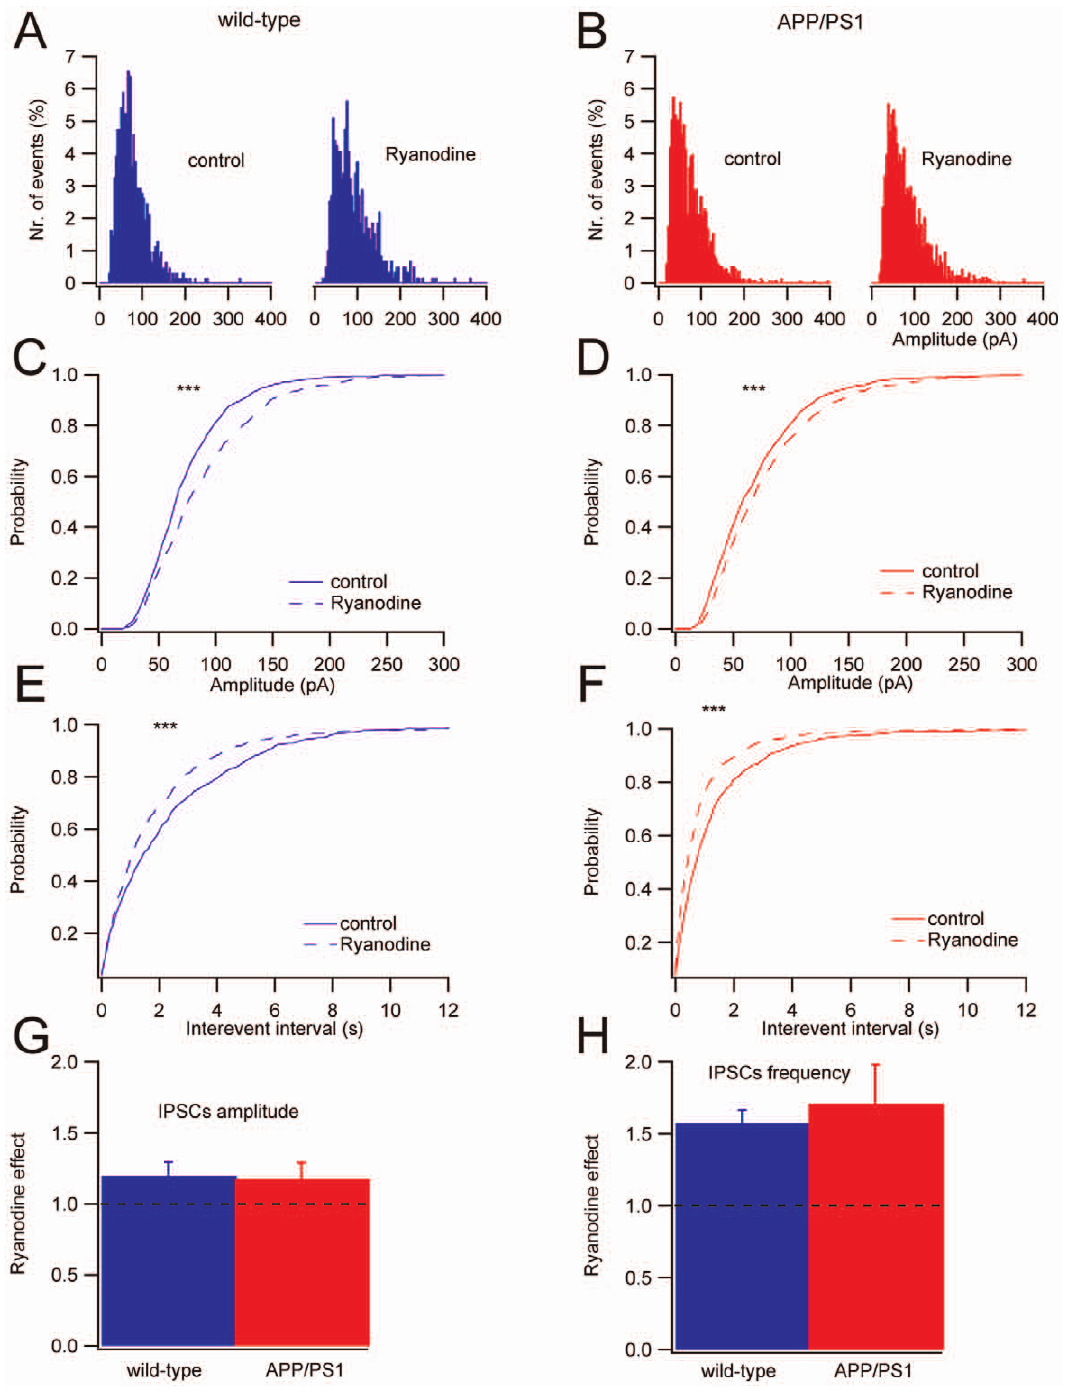
Figure 6. Ryanodine effects on mIPSCs. ( A ) mIPSCs amplitude histograms obtained in control condition and in the presence of ryanodine for wild-type (n=6) and ( B ) for APP/PS1 (n=13) cells. ( C ) Normalized cumulative amplitude histograms for wild-type and ( D ) for APP/PS1 cells (***P , 0.001, KS test). ( E ) Normalized cumulative frequency plot for inter-event intervals for wild-type and ( F ) APP/PS1 cells (***P , 0.001, KS test). ( G ) Ryanodine effect on the mIPSCs amplitude and ( H ) frequency for wild-type and APP/PS1 PCs. The effects of ryanodine relative to the controls before application are significant (P , 0.01, Student’s paired t-test) but no significant difference is present between genotypes.